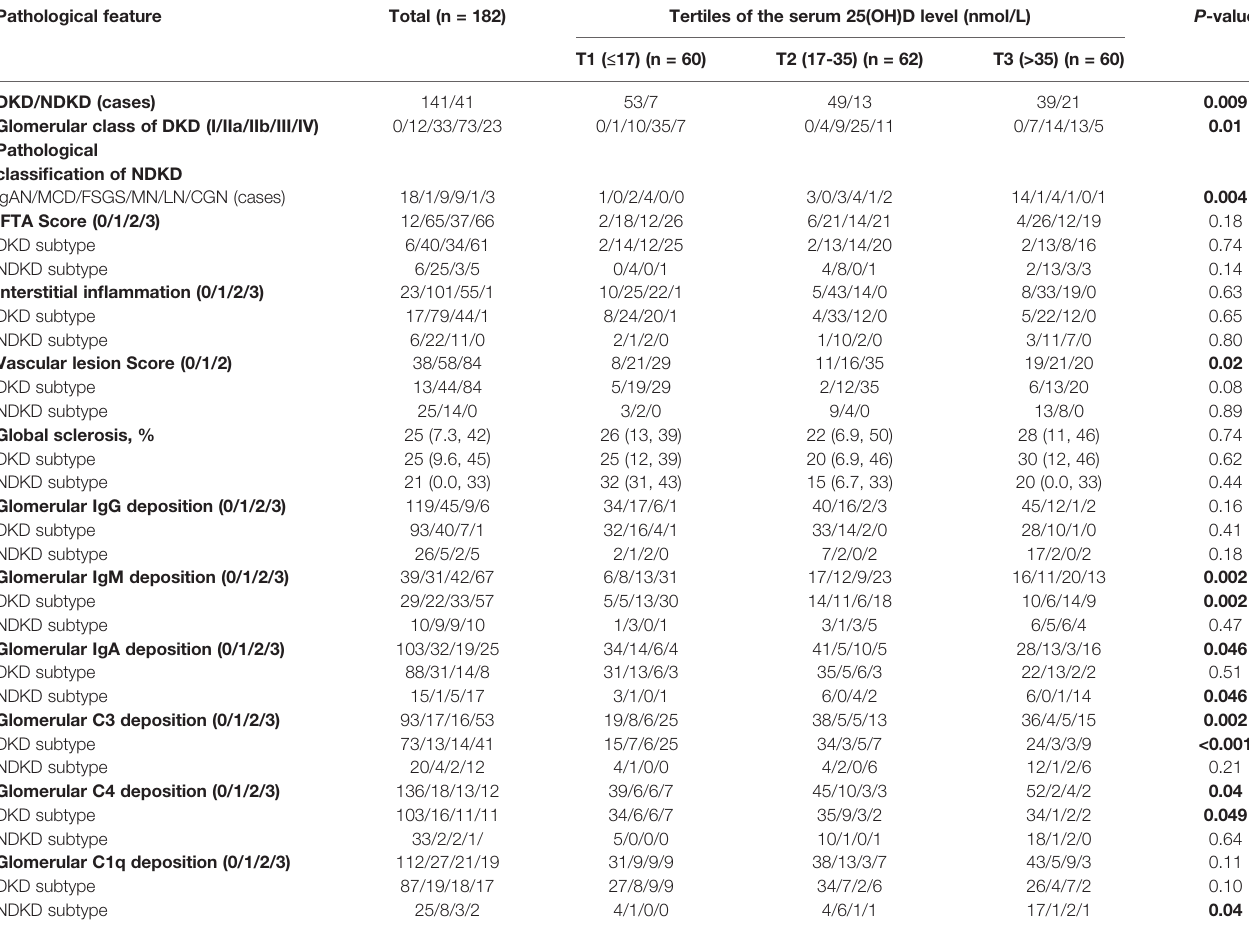
TABLE 3 | Pathological features of all enrolled patients according to tertiles of vitamin D level. Pathological